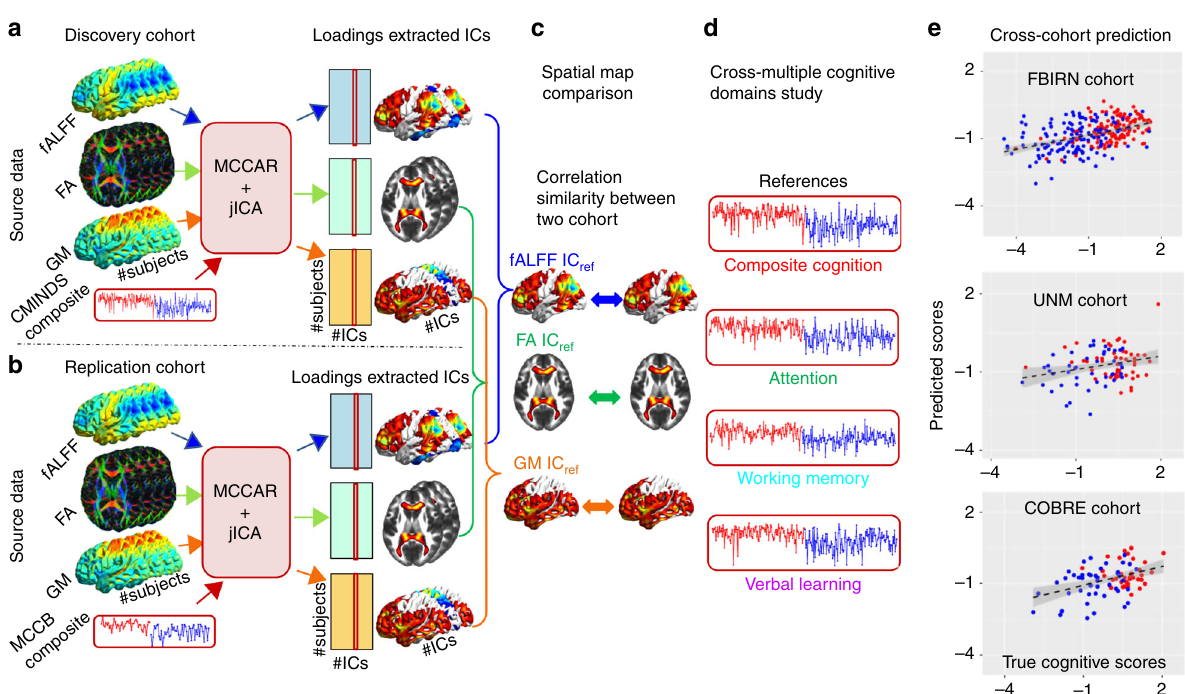
Fig. 9 Flowchart of cognition-directed multimodal fusion and prediction analysis. First, cognitive scores of a CMINDS composite score and b MCCB composite score were set as the reference to guide the three-way MRI fusion for the discovery cohort and replication cohort respectively. c To test the similarity of the identi fi ed neuromarker between cohorts, we compared the permuted spatial correlation between brain maps, and summarized the most affected cognitive domains related to schizophrenic de fi cit. d Furthermore, cognitive domain scores of attention, working memory, and verbal learning were used as reference to guide the three-way MRI fusion respectively, aiming to identify the domain-speci fi c neuromarkers. e Finally, after extracting the neuromarker maps across multiple domains, we built multiple linear regression models to predict individualized cognitive scores of FBIRN cohort. The achieved models were further successfully generalized to predict corresponding cognitive measures in two independent cohorts (UNM and FBIRN prediction was then applied to the regressors obtained from UNM and COBRE data. Pearson correlations between true and predicted cognitive scores of each domain were assessed, as seen in Figs. 7, 8 and 9e. Based on the CMINDS regression model obtained from FBIRN cohort, if the estimated MCCB scores of UNM and COBRE cohorts are signi fi cantly correlated with the true MCCB scores, the generalization of predictability of cognition based on the four selected neuro- markers can be recognized to some degree. The beta weights of linear regression models for each predicted cognitive domain are displayed in Fig. 8.